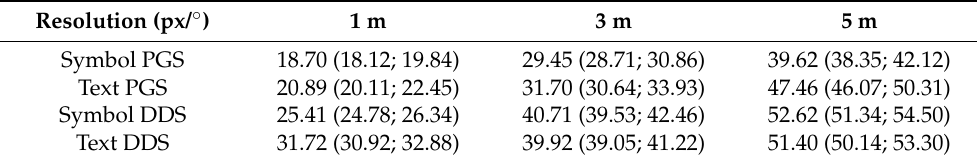
Table 2. Effective resolution on the ground for a 90% threshold level evaluated by the participants for text- or symbol-based projection content under different adaptation luminance levels defined in pixels per degree (px/ ◦ ). The numbers in brackets indicate the confidence intervals of 95%, with the lower bound as the first number and the higher bound as the second number of the perceived resolution on the street for every distance, ambient lighting and projection content.